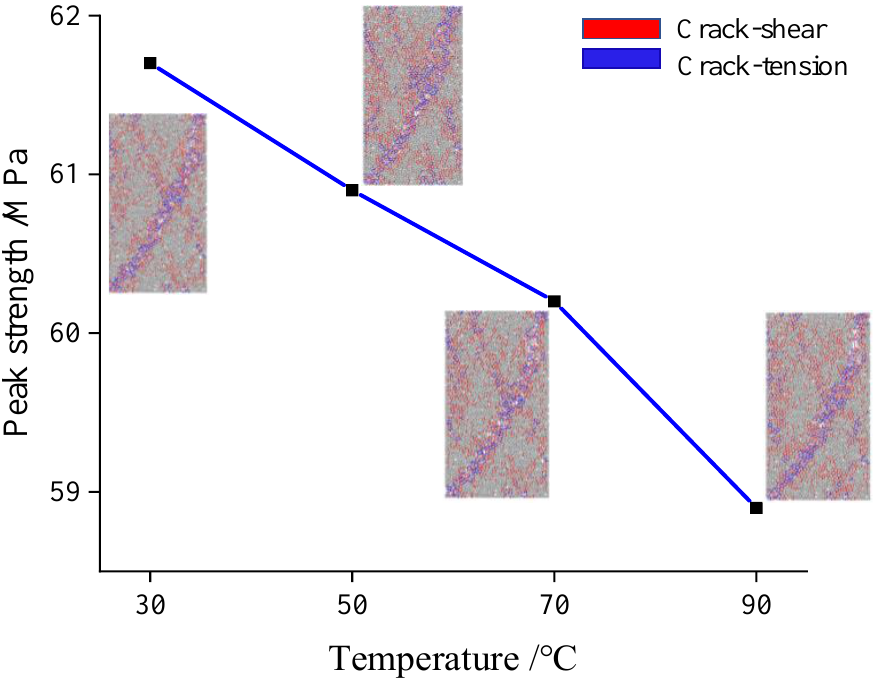
Figure 8. Variation of peak stress with temperature and crack distribution under peak stress at 5 MPa.